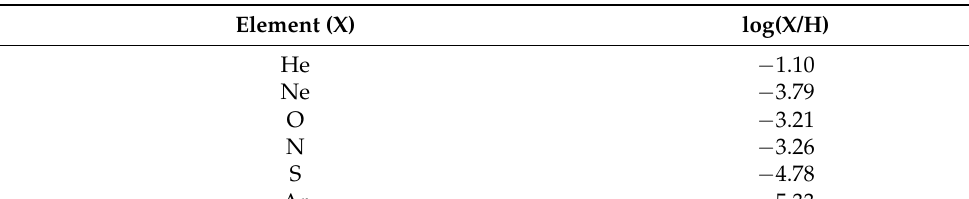
Table 2. Preliminary results of the elemental abundances of the PN BMP J1613-5406 as estimated from our VLT/FORS2 spectral data.